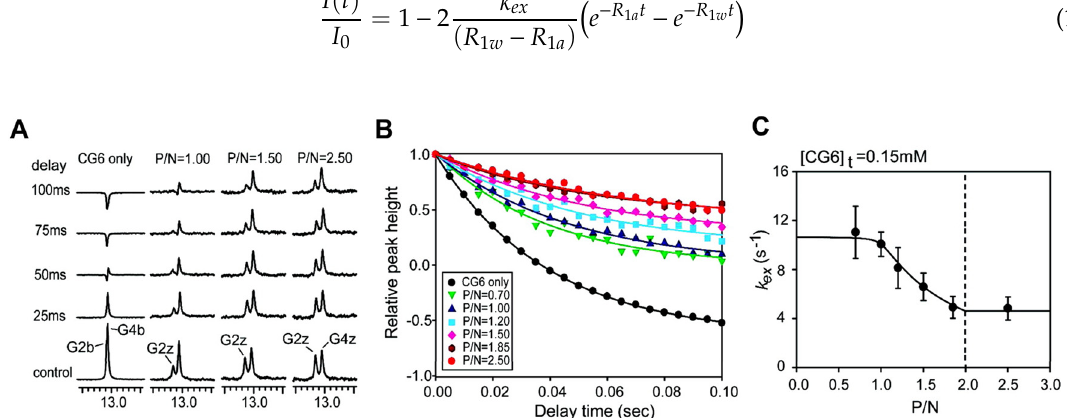
Figure 7. ( A ) One-dimensional imino proton spectra of the water magnetization transfer experiments. P, protein; N, nucleotide. ( B ) Relative peak intensities in the water magnetization transfer spectra for G2z imino resonances as a function of delay time. ( C ) Exchange rate constants of the G2z imino protons as a function of the hZ α ADAR1 :d(CG) 3 molar ratio (P / N ratio). Reprinted with permission from Ref. [145]. Copyright 2009 American Chemical Society.